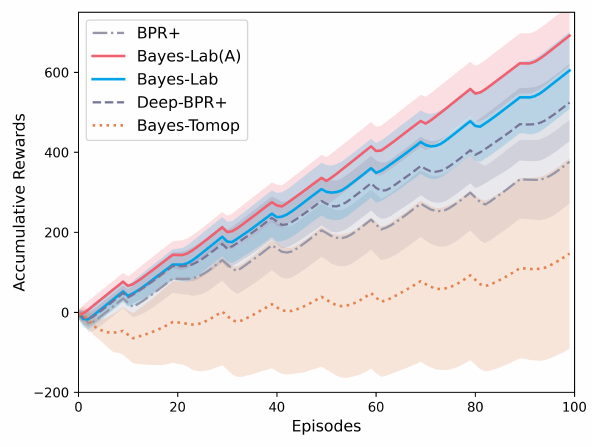
Figure 9. The accumulative rewards for 100 episodes of interactions.